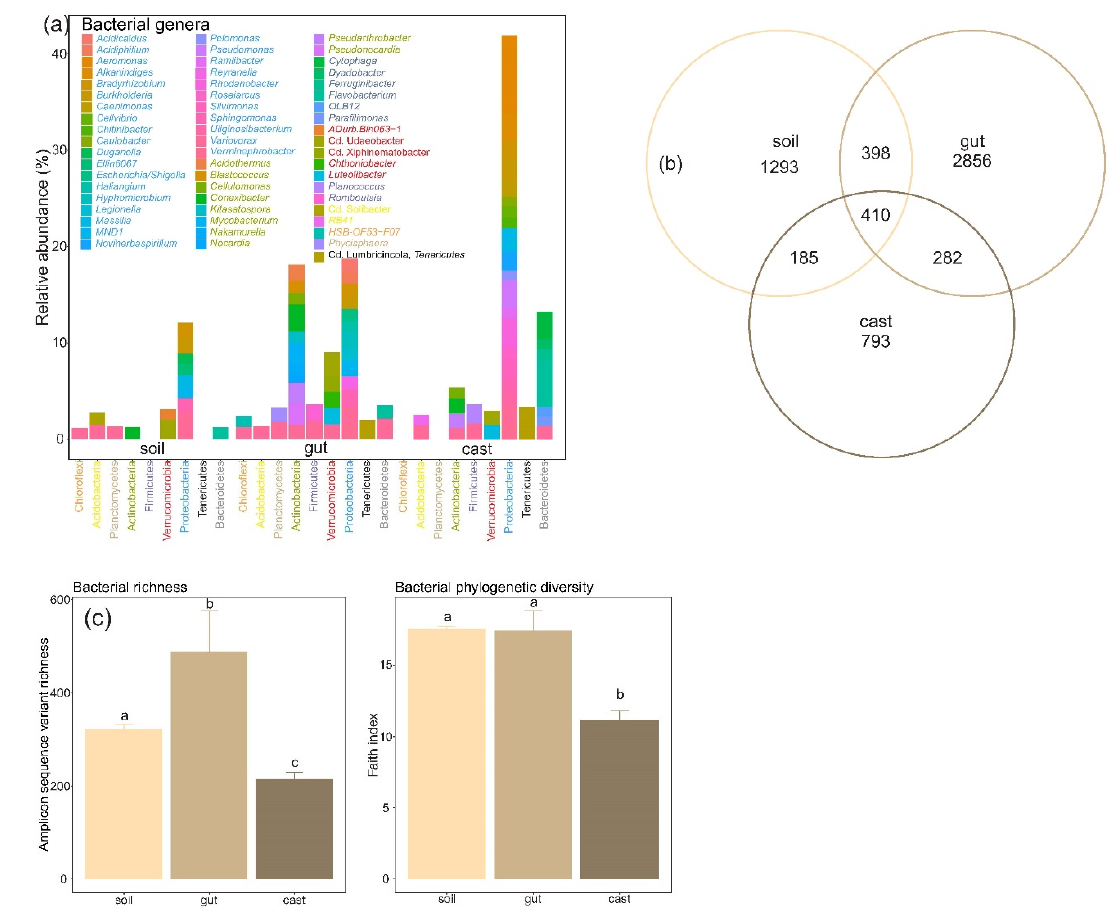
Figure 1. Changes in composition and diversity of soil microbiomes during and after gut transit in the earthworm Aporrectodea caliginosa . ( a ) Relative abundance of main bacterial phyla and genus (those with relative abundance >1%), ( b ) Venn diagram representing the number of shared ASVs between soil, gut and casts using the full data set as well as the unique ASVs of each type of sample. ( c ) Changes in taxonomic and phylogenetic α -diversity. Letters indicate significant differences between time points (Tukey HSD test).